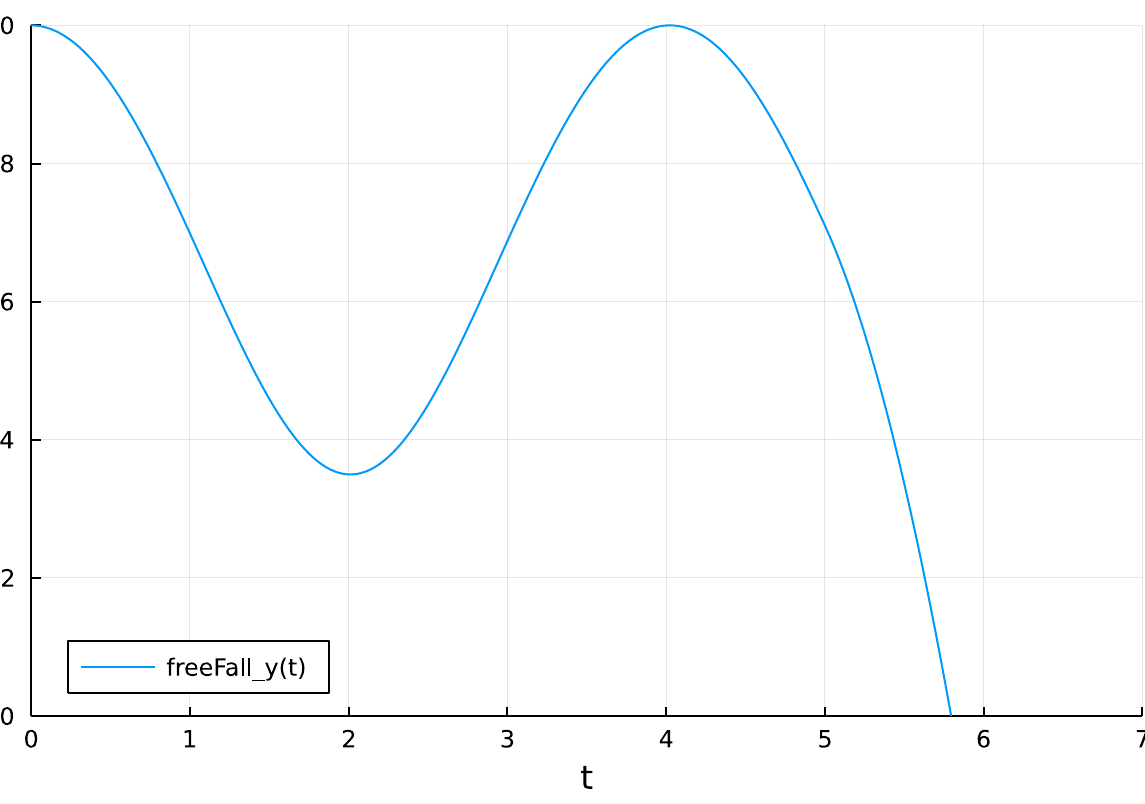
Figure 7. The result of simulating Listing 13. Note that the legend provides the prefix of the last active model which was FreeFall . The behavior before the structural transition at t = 5 is described by the equations of the pendulum